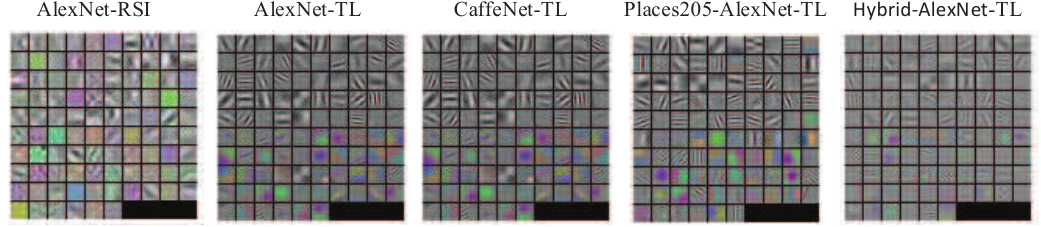
Figure 18. Visualization of the first-level convolutions in different network models.